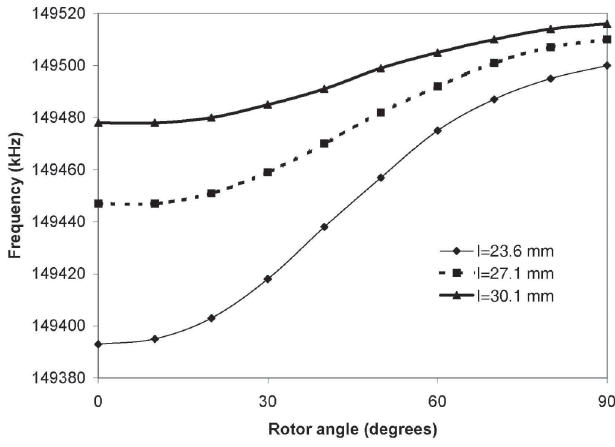
FIG. 7. Rotary tuner frequency ranges for 3 distances to the stub ends.